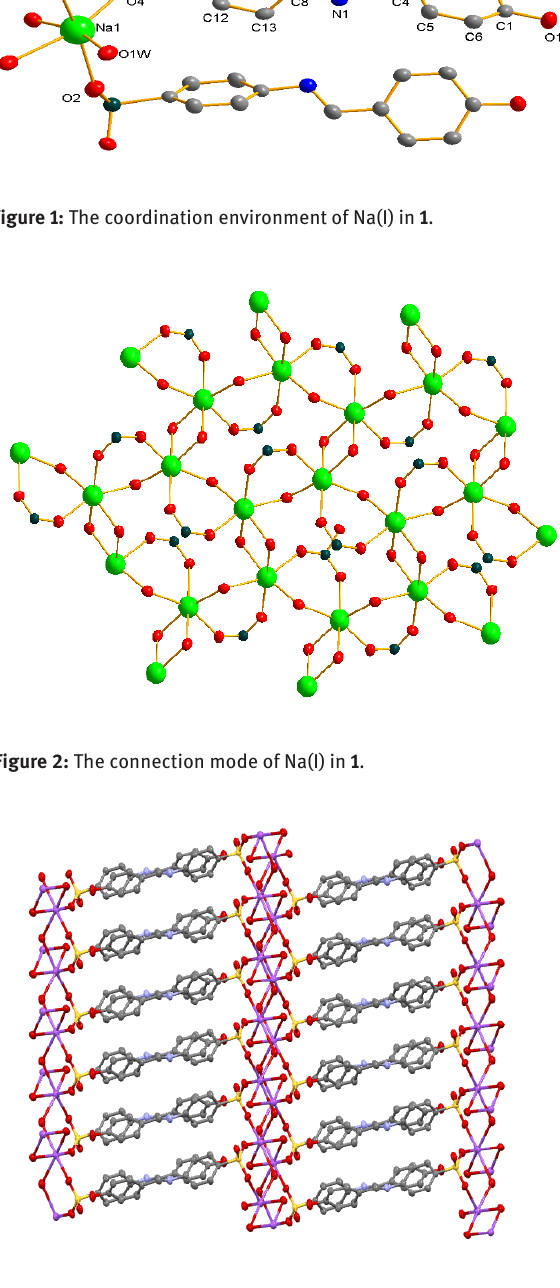
Figure 3: 2D layered structure of Na(I) coordination polymer .